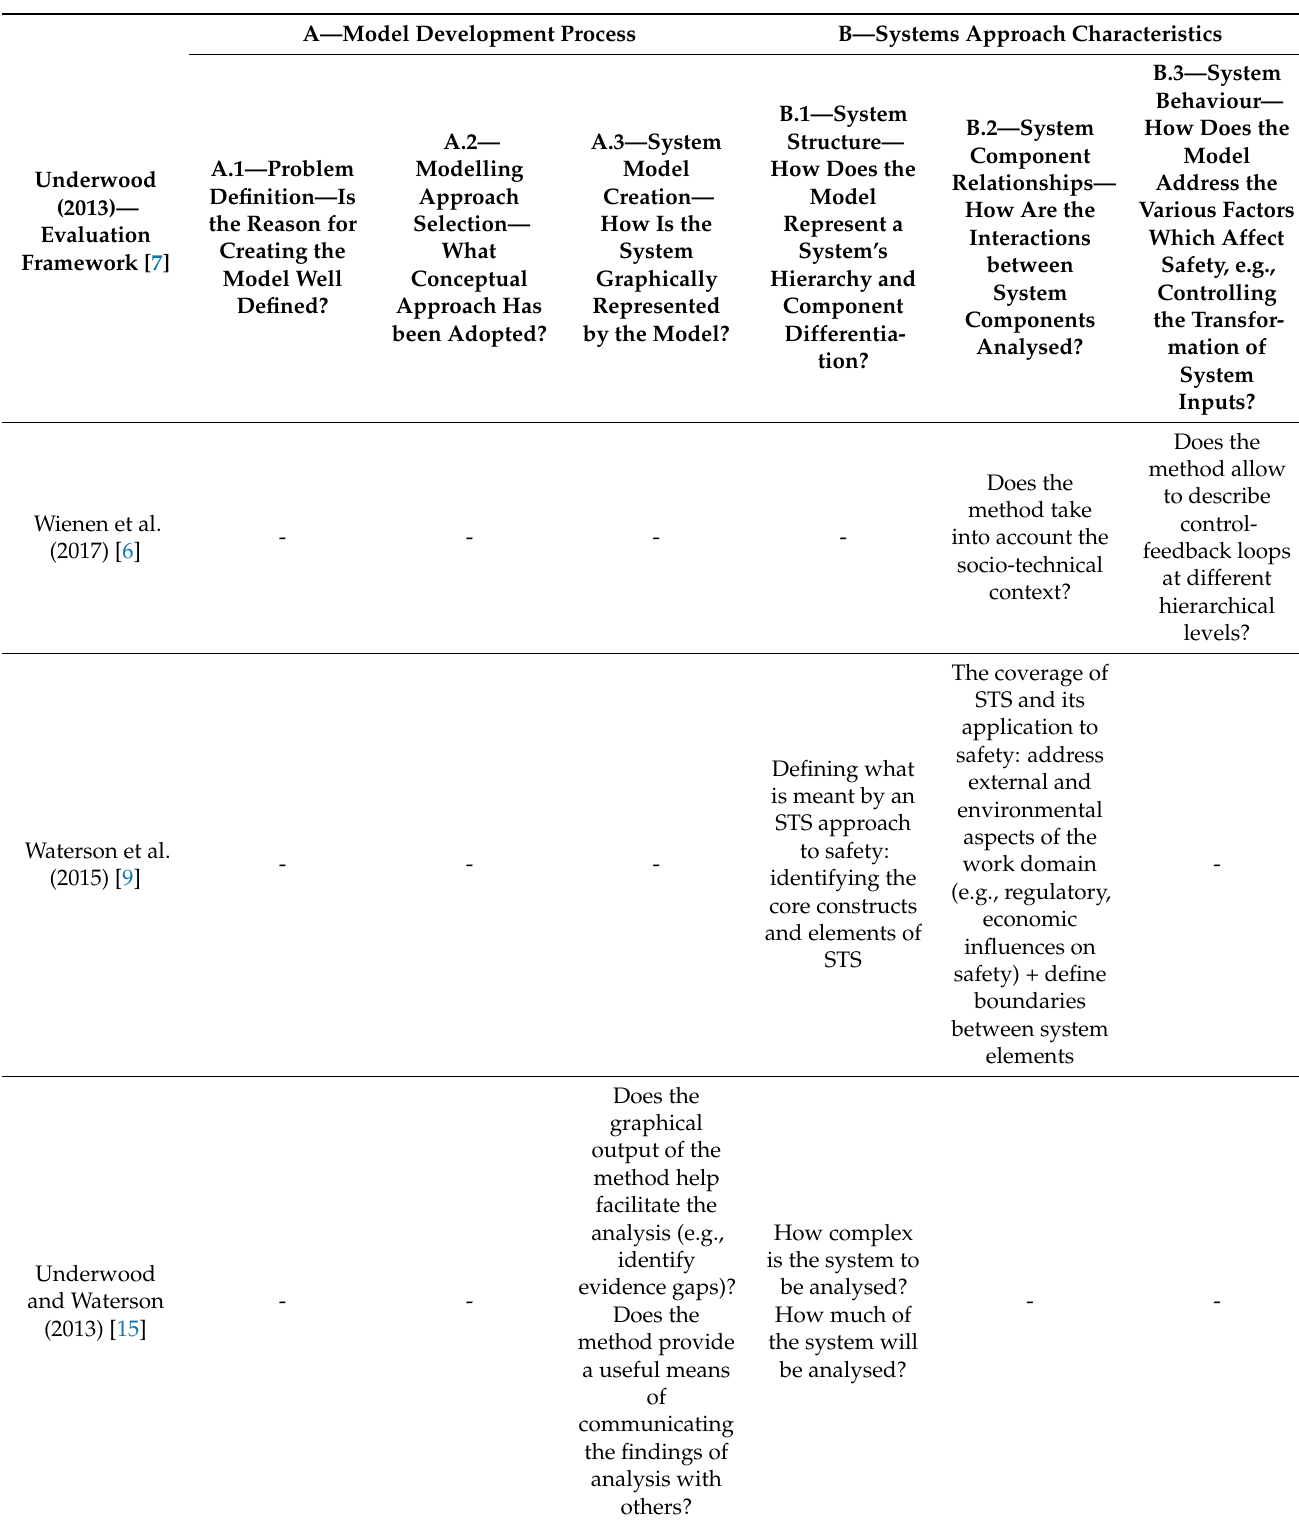
Table A1. Comparing Underwood’s evaluation framework with other